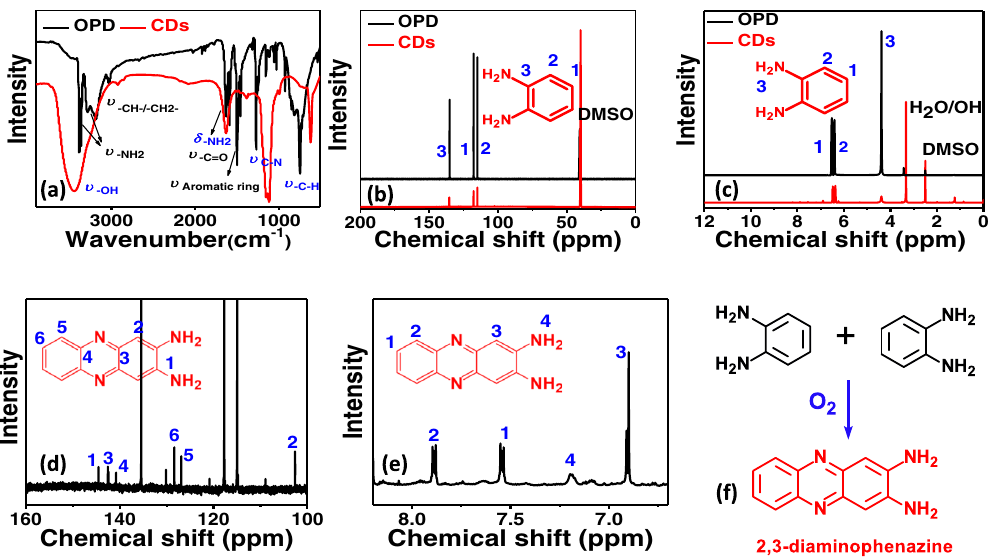
Fig. 3 Identi fi cation of functional groups on CDs. a – c Fourier transform infrared spectroscopy (FTIR), 13 C-NMR and 1 H-NMR spectra of OPD and CDs; d , e zoomed 13 C-NMR and 1 H-NMR spectra of CDs. f Schematic showing the procedure of oxidizing OPD into